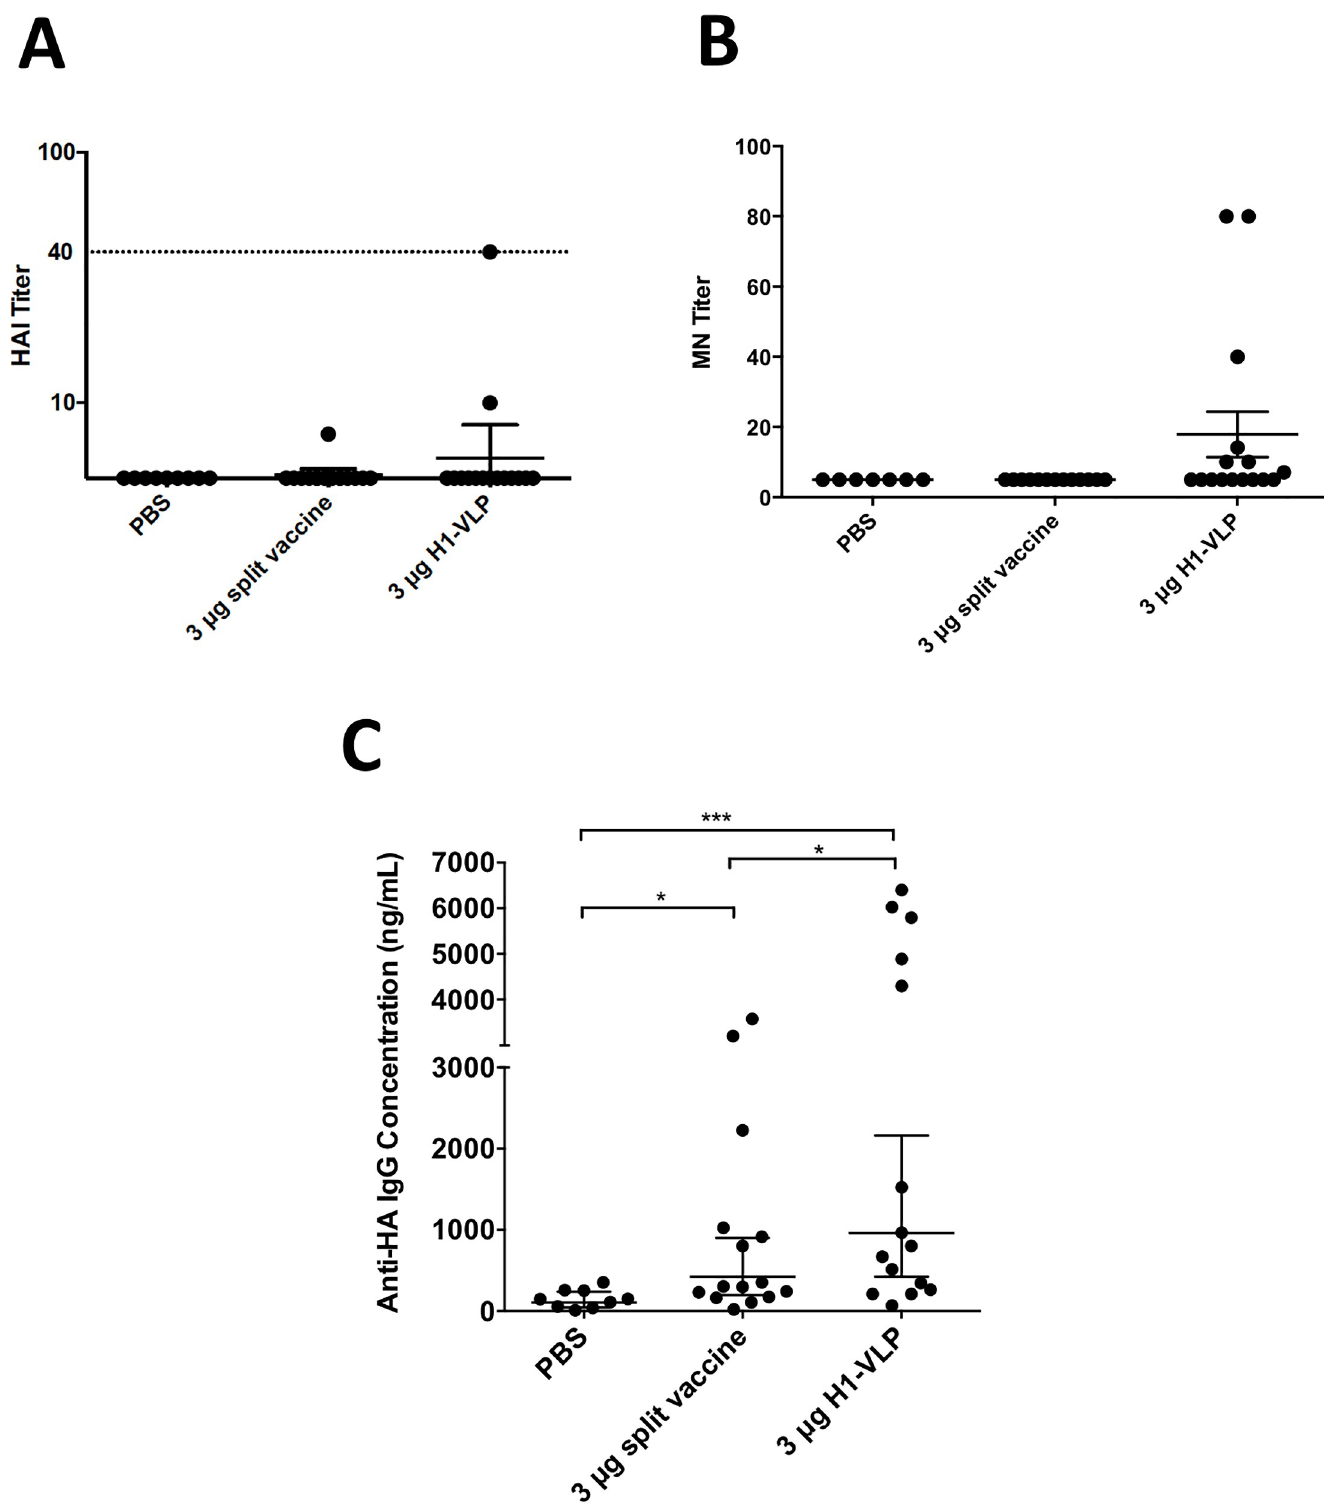
Fig 1. Serum antibody response after two doses of H1-VLP or split-virion vaccine. Aged (24–26 months) BALB/c mice were immunized twice with H1-VLP, split- virion vaccine or PBS. Three weeks post-boost sera from individual mice were analyzed by Hemagglutination Inhibition (HI) (A) and microneutralization (MN) (B) titer against A/California/07/2009 H1N1. Influenza HA-specific IgG concentrations (C) by ELISA. Dotted line in A) represents 40 HAI which is considered the